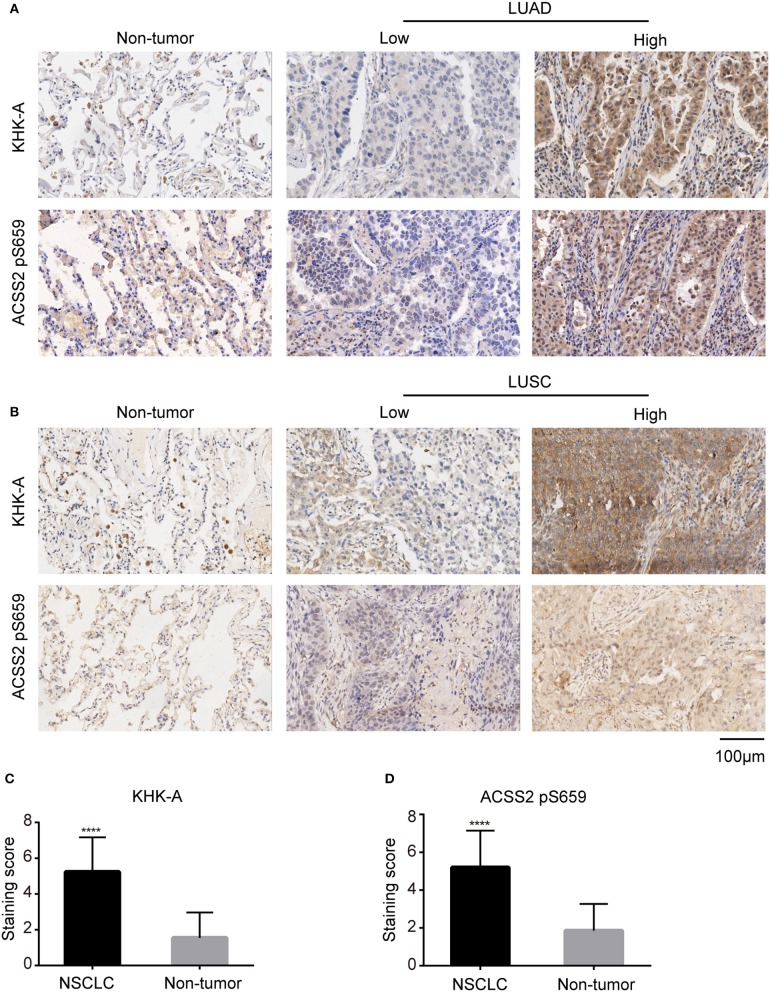
NSCLC specimens have increased KHK-A and ACSS2 pS659 expression levels. (A,B) Representative IHC staining of low and high expression of KHK-A and ACSS2 pS659 in NSCLC tissues and adjacent non-tumor tissues (N = 303). (A) LUAD, (B) LUSC. Scale bar, 200×, 100 μm. (C,D) The expression levels of KHK-A (C) and ACSS2 pS659 (D) in NSCLC and adjacent non-tumor tissues were compared by IHC staining. ****Correlation is significant at the 0.0001 level (two-tailed).